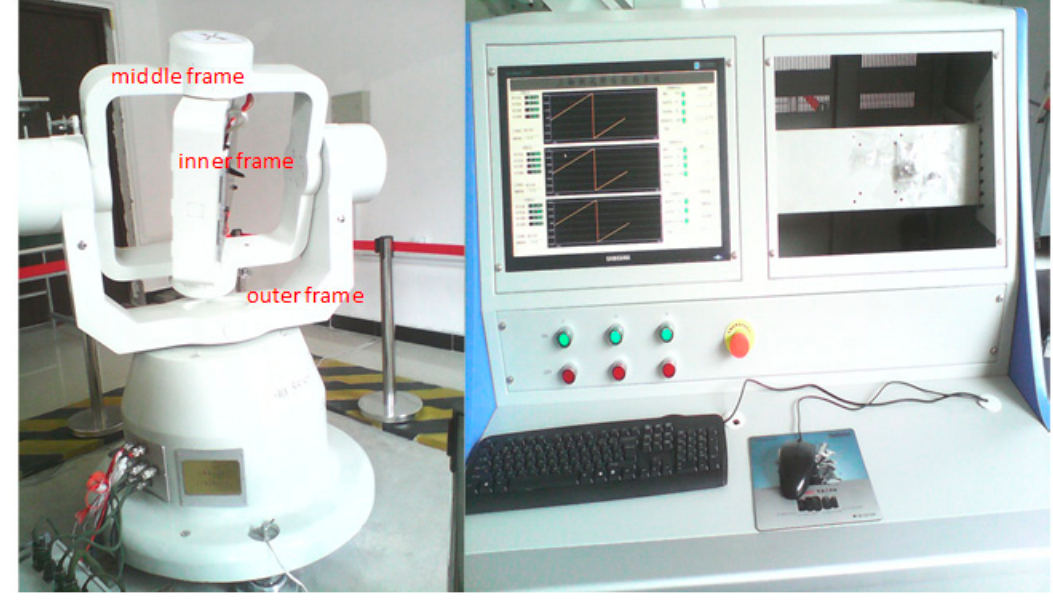
Figure 3. Tri-axial rotation platform.